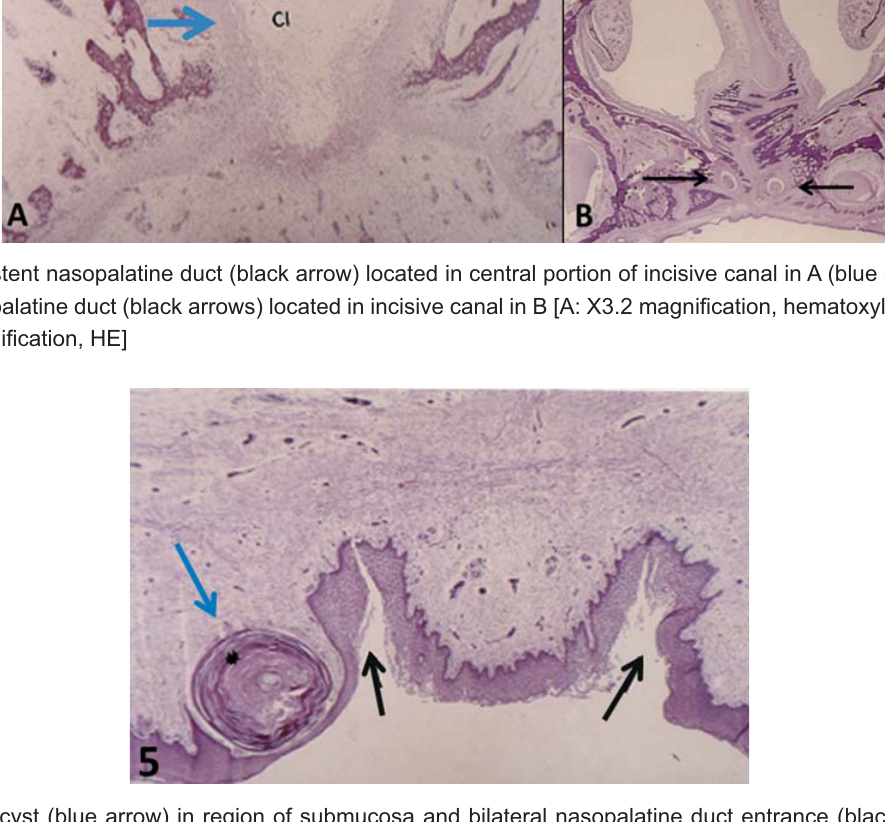
Figure 5- Horn cyst (blue arrow) in region of submucosa and bilateral nasopalatine duct entrance (black arrows)